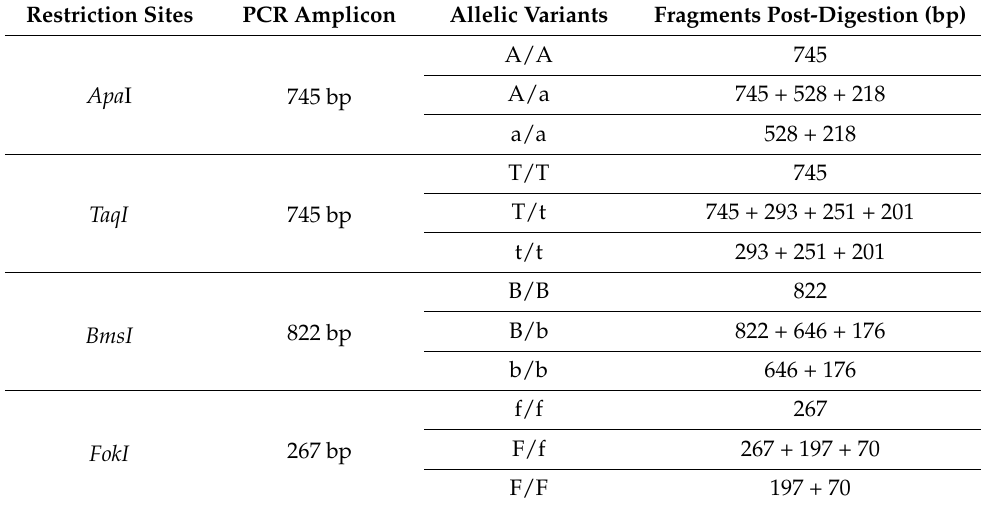
Table 3. Characteristics of VDR PCR-restriction fragment length polymorphism (PCR-RFLP)